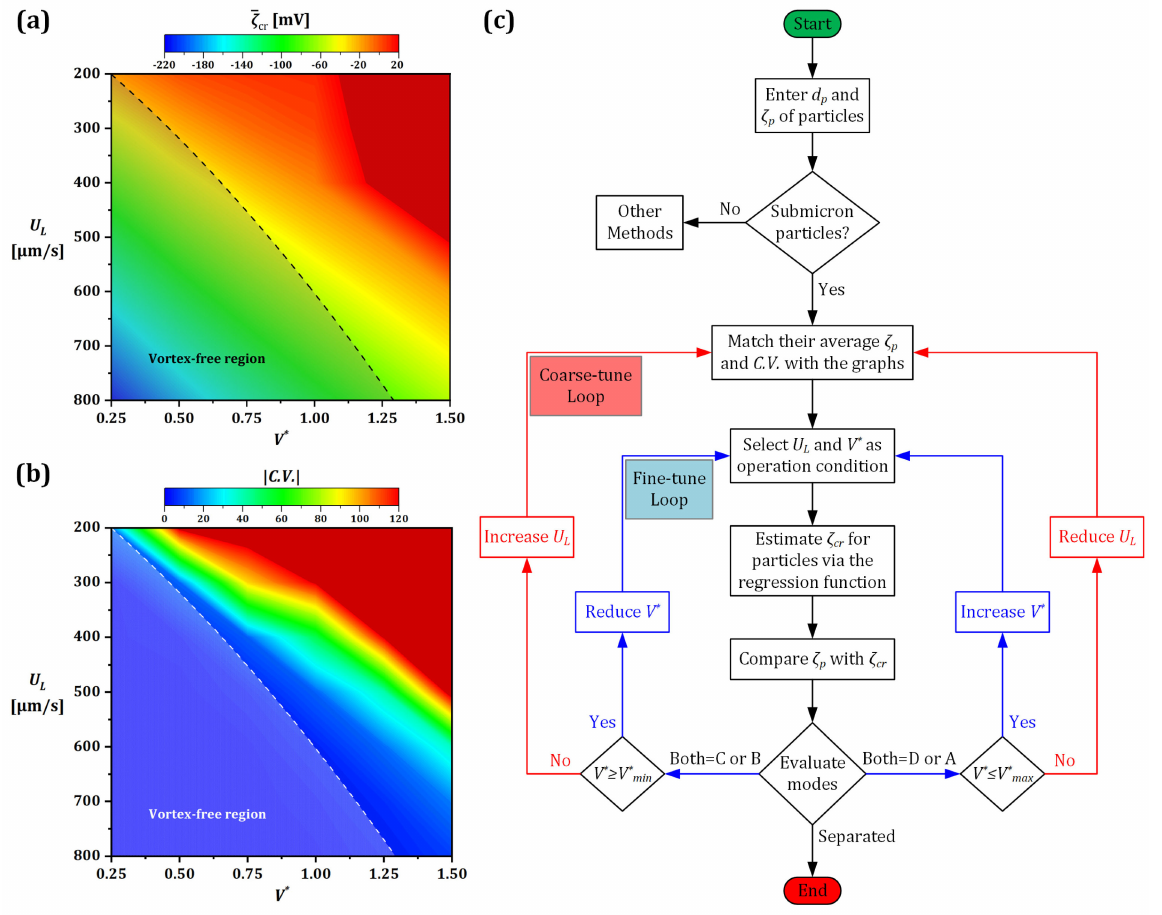
Figure 9. An algorithm for the separation of two particles of different sizes and charges. ( a ) The contours of the average critical zeta potential and ( b ) its absolute coefficient of variation for submicron particles. The scarlet region approximately with U L < 500 [ µ m/s] and V ∗ > 1.1 is unpredictable